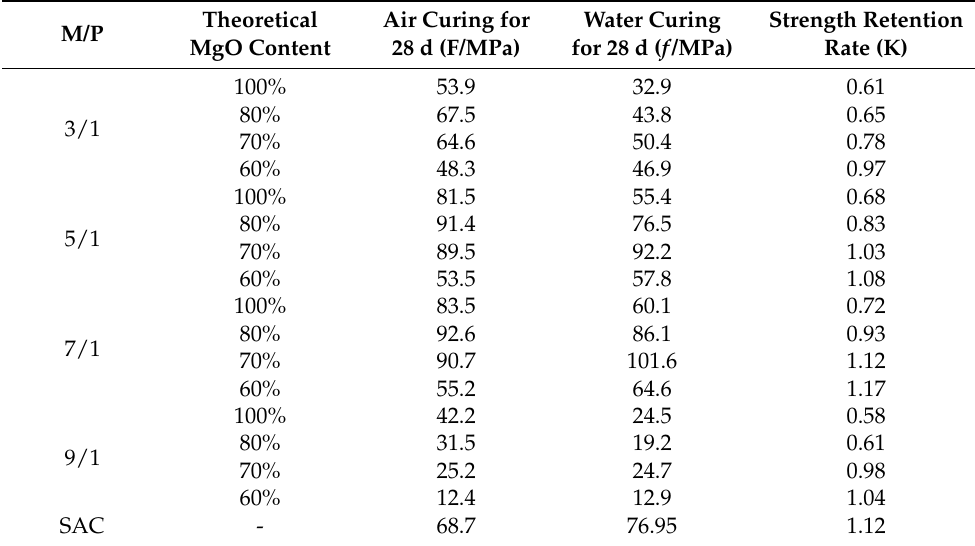
Table 7. Strength retention rate under different curing conditions.